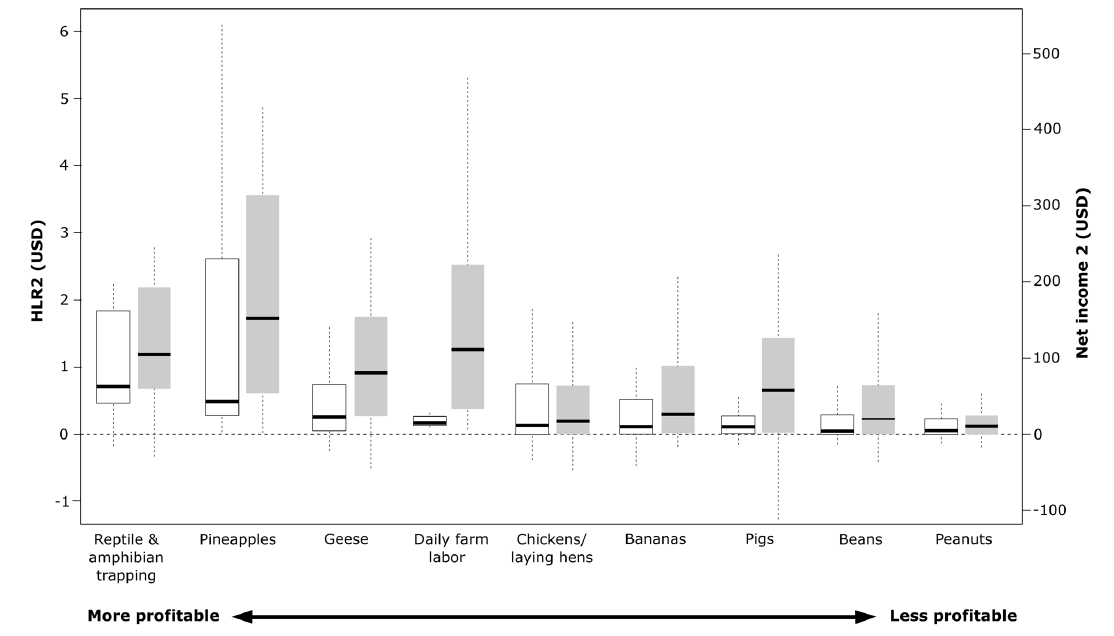
Fig. 2 . Household livelihood return (HLR2) and net income (2) for the nine most profitable livelihood activities (those where HLR2 > $0.1 per hour). Unshaded boxes depict left hand axes “HLR2” and shaded boxes depict right hand axes “Net Income 2.” Horizontal line shows median, box shows interquartile range, and the whiskers depict the maximum and minimum values. Those furthest to the left have the highest median HLR2. There